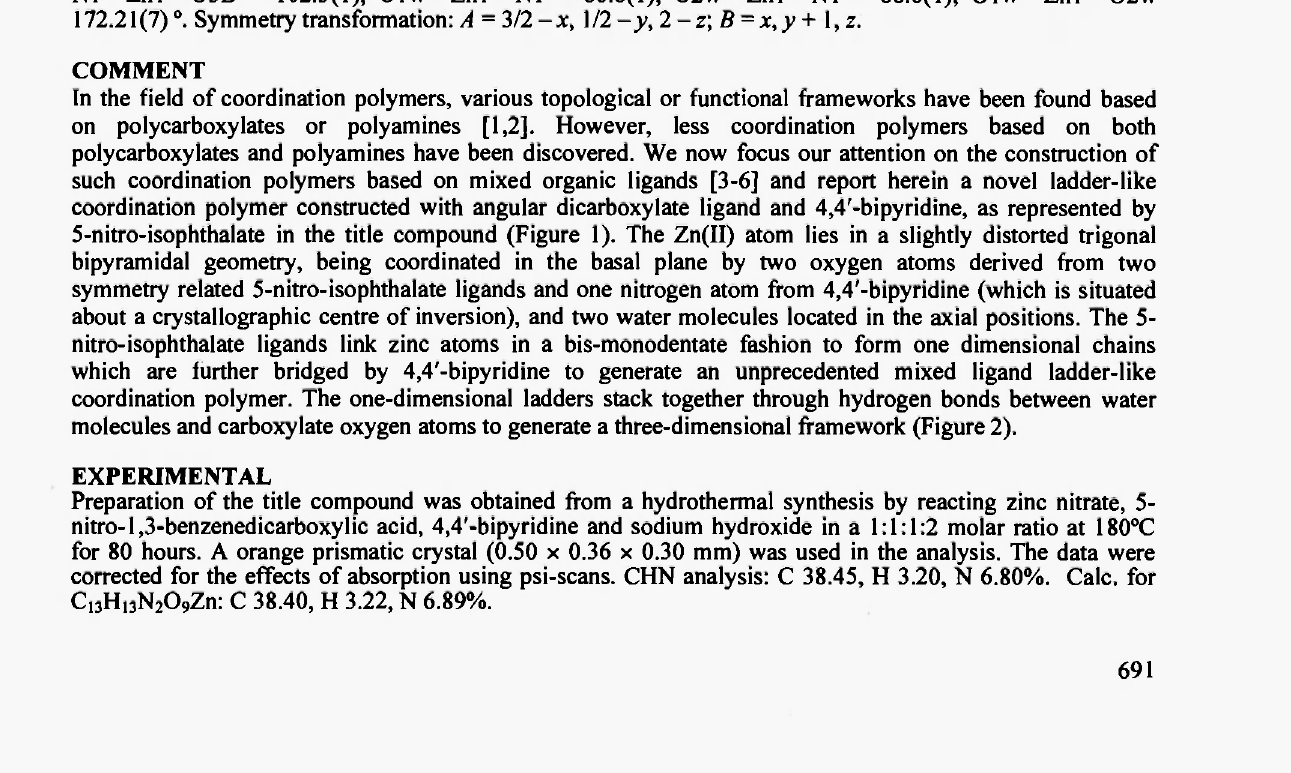
Figure 1. ORTEP plot of the title complex at the 50% probability level. Selected bond distances and angles: Znl—Ol = 1.931(2), Znl—03B